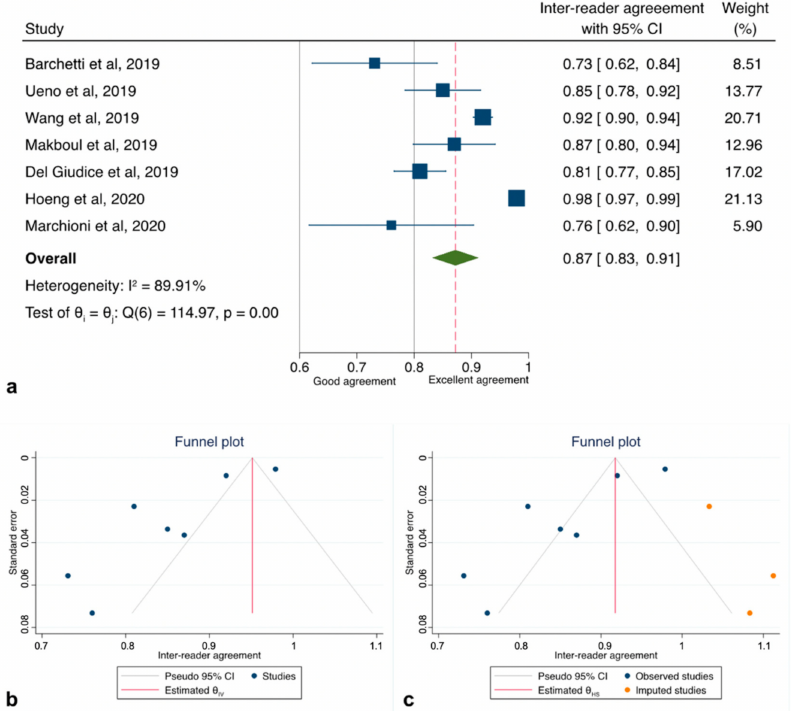
Figure 2. Pooled inter-reader agreement for the studies included in the quantitative analysis. ( a ) Forest plot reporting the pooled inter-reader agreement among the 7 studies analyzed (excluding Sakamoto et al.); ( b ) Deeks’ funnel plot (test for small-study e ff ect, p < 0.001); ( c ) “Trim and Fill” method suggesting imputed studies missing to remove asymmetry from the funnel